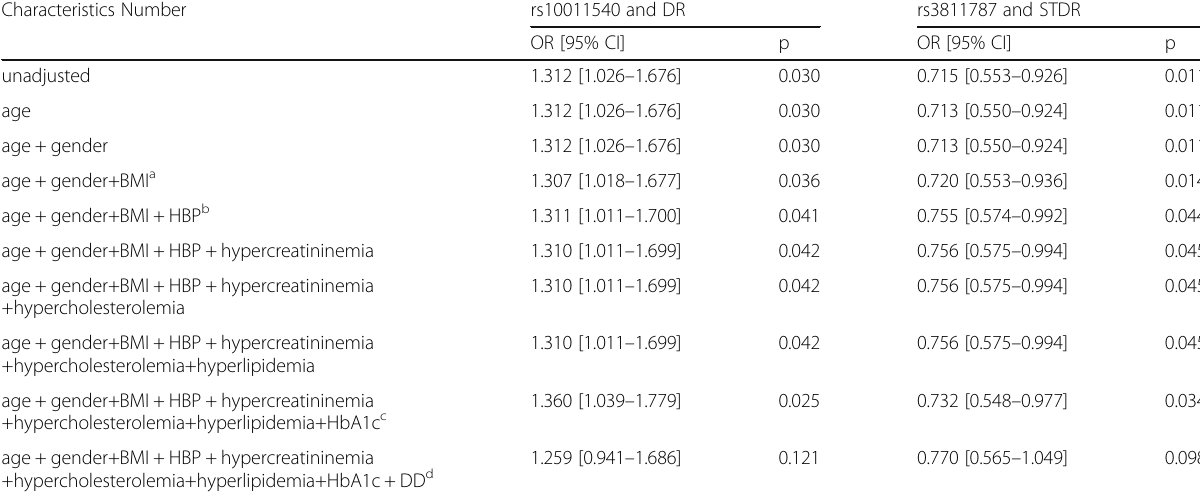
Table 3 The association of SNPs and diabetic retinopathy after adjustment for environmental factors Characteristics